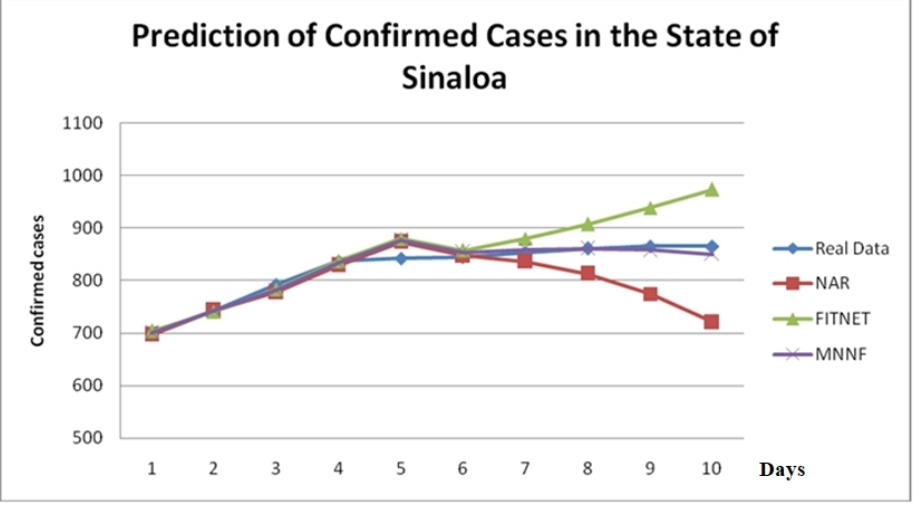
Figure 11. Comparison of prediction of confirmed cases for the state of Sinaloa.